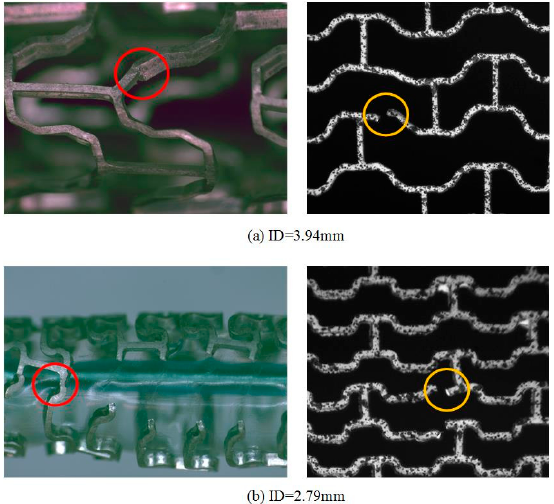
Figure 17. Fracture spots in the struts of stents with ( a ) Pattern B and ( b ) Pattern C in comparison with those in the planar specimens.